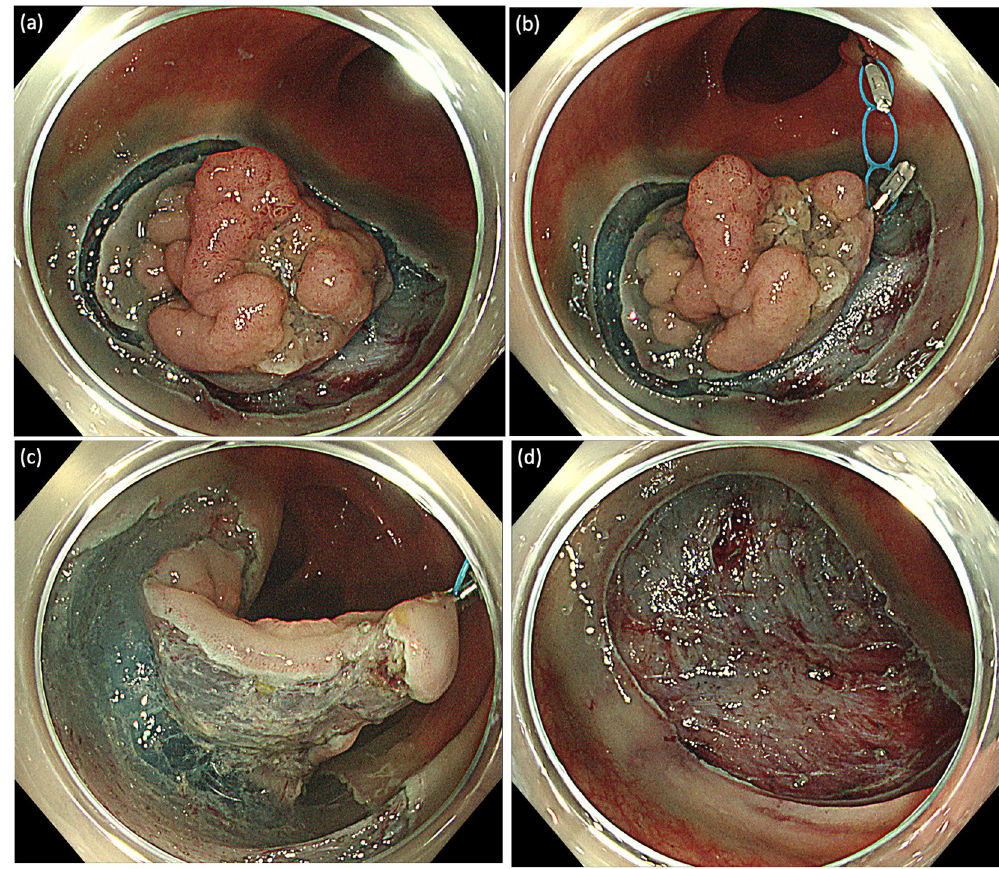
Figure 1. Strategies used for colorectal endoscopic submucosal dissection (ESD) using the multi-loop traction device (MLTD). ( a ) Full circumferential mucosal incision around the lesion. ( b ) Attaching the MLTD on the mucosal edge to elevate it. ( c ) The visual field of the submucosa and muscle layer is good, allowing for safe submucosal dissection. ( d ) En bloc resection of the lesion was successful and without intraoperative complications.